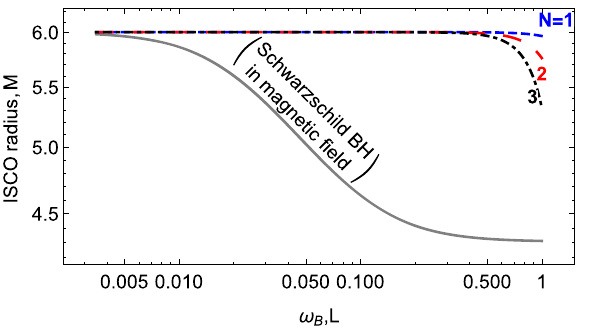
Fig. 13 Relationbetweentheconformalparameter L andthemagnetic coupling parameter ω B for the same ISCO radius of charged particles and different values of the conformal parameter N